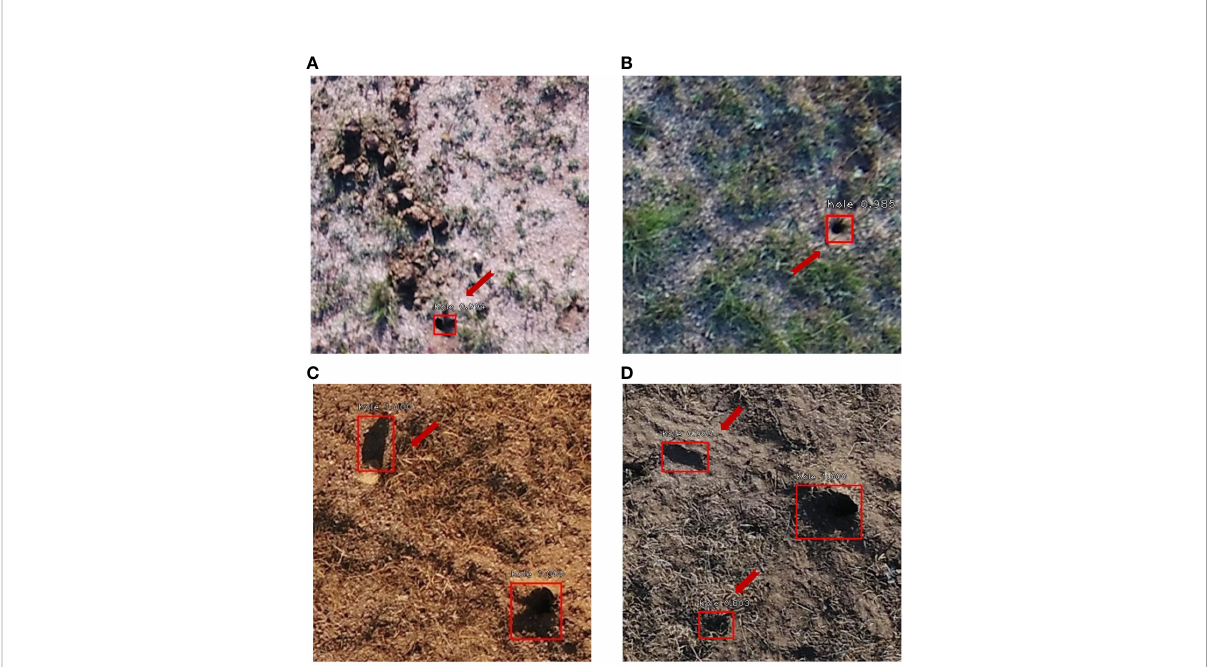
FIGURE 8 Examples of False Positive (FP) (red arrows): (A) cow dung, (B) shadows of grass, (C) shadows of rocks (the upper left), and (D) shadows of rocks (the upper left) and grass (the lower left). Predicted BV holes are in red boxes.